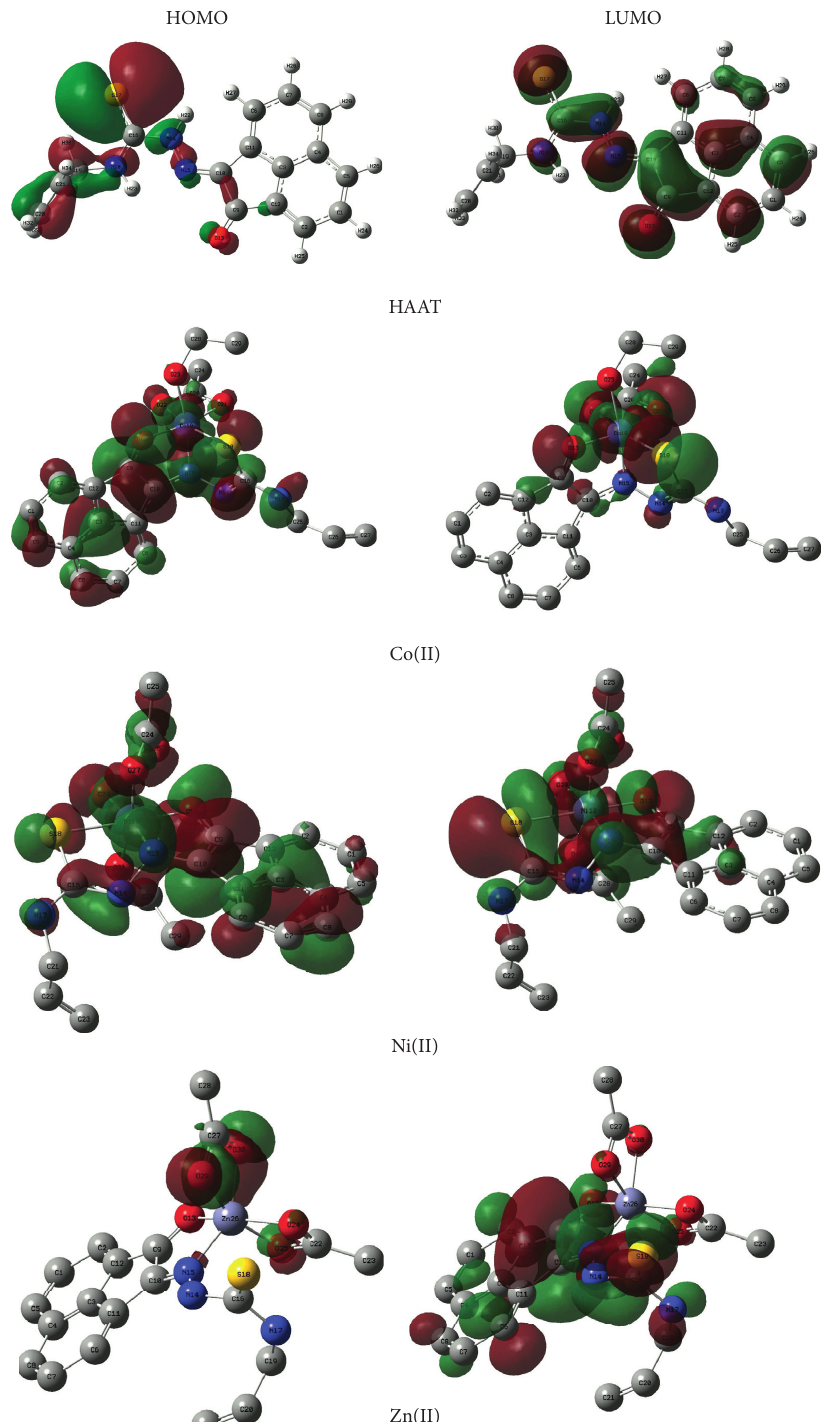
Figure 10: The 3D plots of the investigated compound HOMO and LUMO